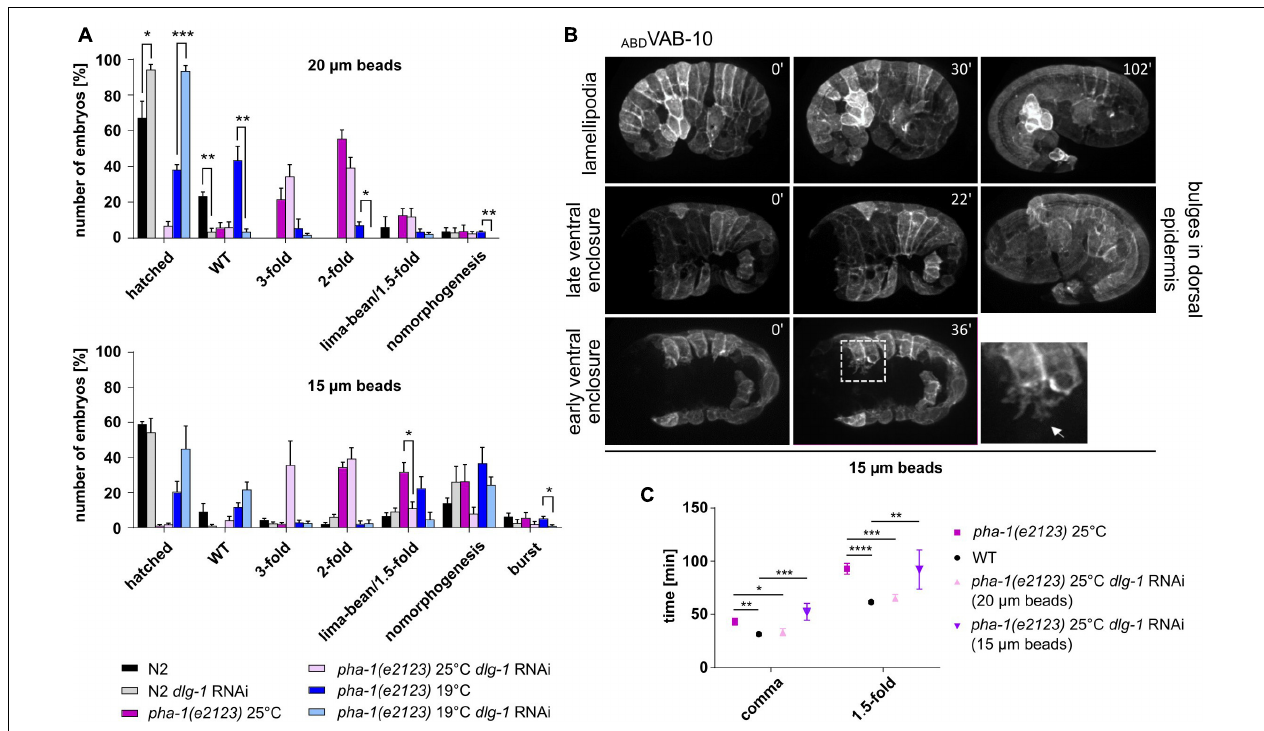
FIGURE 7 | Uniaxial compression partially phenocopies pha-1(e2123) . (A) Comparison of developmental arrest of WT and pha-1(e2123) embryos mounted with 20 or 15 µ m microspheres. Embryos were maintained either at the non-permissive temperature of 25 ◦ C or at the threshold temperature of 19 ◦ C with or without preceding dlg-1 feeding RNAi (with SEM, n ≥ 90). (B) Maximum projected stills from time lapse microscopy of embryos expressing lin-26 p::ABD VAB − 10 ::mCherry, mounted with 15 µ m microspheres. Embryos often exhibit halt of ventral enclosure at any given progression state with ventral cells forming large actin-rich protrusions (arrow in detailed view). In rare cases epidermal cells form large lamellipodia (upper row) or bulges in the head hypodermis (right panel). (C) Quantification of elongation time (from lima-bean to 1.5-fold stage) in WT and pha-1(e2123) embryos maintained at 25 ◦ C and mounted with 20 or 15 µ m microspheres with or without preceding dlg-1 RNAi (with SEM, n = 4–8). T-test: * p < 0.05; ** p < 0.01; *** p < 0.001; and **** p <